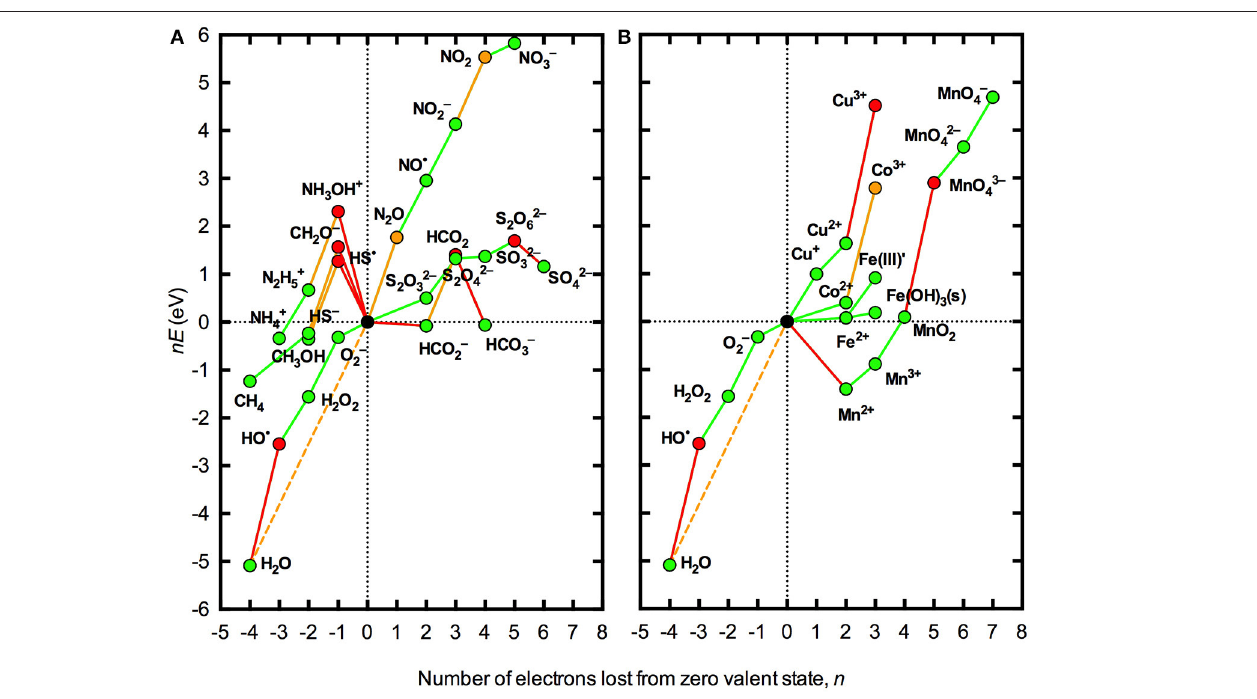
FIGURE 1 | Frost diagrams for some common redox active elements in natural waters under standard conditions at pH 8.1. (A) Representative species for the major elements C, N, and S. (B) Trace metals Co, Cu, Fe, and Mn. All redox potentials ( E ) are defined with reference to the standard hydrogen electrode at pH 8.1 (Pt,H 2 | a H + = 10 − 8.1 ). The compounds shown represent the dominant acid-base species at pH 8.1, allowing for hydrolysis of trace metals. The zero valent states for the elements shown are a representative carbohydrate “CH 2 O” equivalent to 1/6 of a glucose molecule (Morel and Hering, 1993), N 2 (g), S 8 (s), Co 0 (s), Cu 0 (s), Fe 0 (s), Mn 0 (s), and O 2 (aq). Where the necessary thermodynamic data were available, one-electron transfer steps are shown. Red lines indicate redox couples that are unstable with respect to one-electron transfer processes involving the H 2 O/HO • couple (lines with positive slope) or the H 2 /H + couple (lines with negative slope); orange lines indicate redox couples that are unstable with respect to multi-electron transfer processes involving the H 2 O/O 2 couple; and green lines indicate redox couples that are thermodynamically permissible in aqueous solution at pH 8.1. The dashed orange line represents the redox potential associated with the four electron transfer for complete reduction of O 2 to H 2 O. Red symbols represent species that are thermodynamically unable to exist due to instability with respect to one-electron transfer processes involving the H 2 O/HO • couple (lines with positive slope) or the H 2 /H + couple; orange symbols represent species that are thermodynamically able to exist in the absence of processes to catalyze multi-electron transfer processes involving the H 2 O/O 2 couple; and green symbols represent species that are thermodynamically able to coexist with both the H 2 /H + and H 2 O/O 2 couples. Thermodynamic relationships used to construct the diagrams are listed in the Appendix in Supplementary Material. The format of the Frost diagrams was adapted from Figures 1.7 and 1.8 in Fraústo Da Silva and Williams